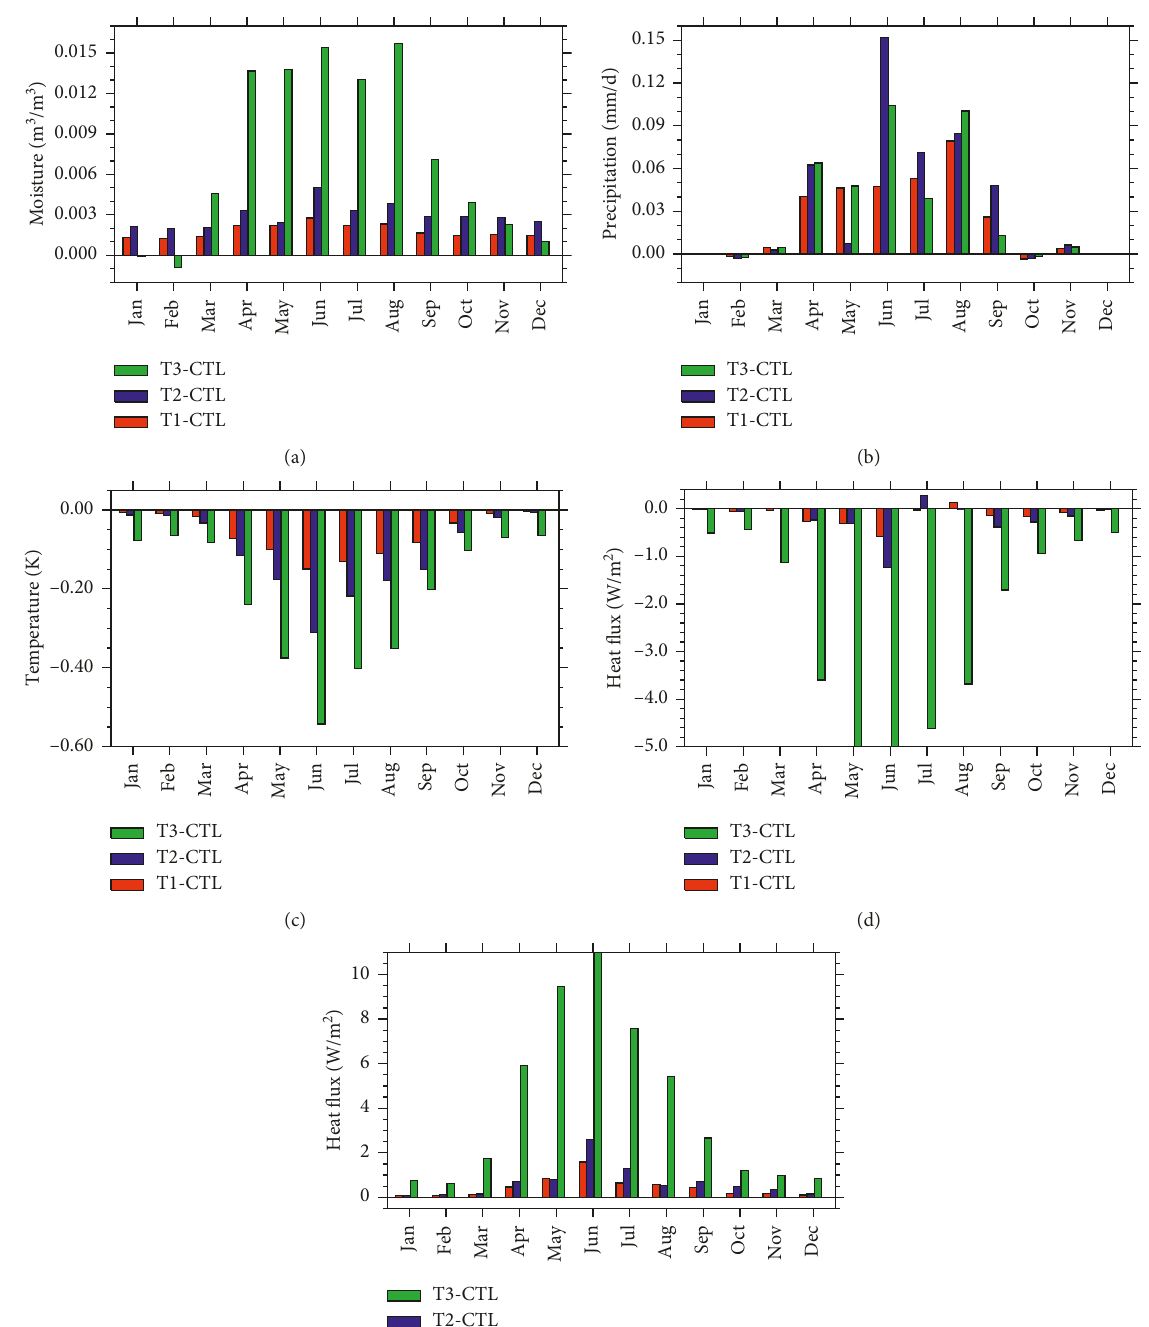
Figure 10: Mean monthly (a) soil moisture differences at 10cm depth, (b) precipitation differences, (c) 2m air temperature differences, (d) sensible heat flux differences, and (e) latent heat flux differences in the Taihang